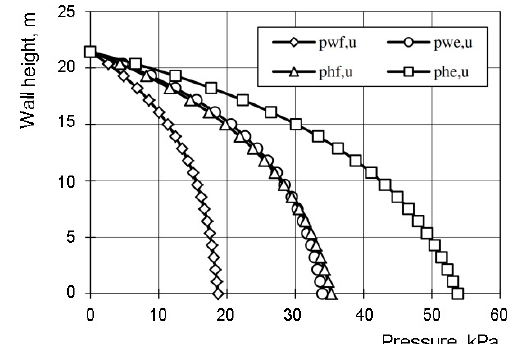
Fig. 2. Diagrams of symetrical and patch load pressures (for filling and discharging) in the vertical silo wall